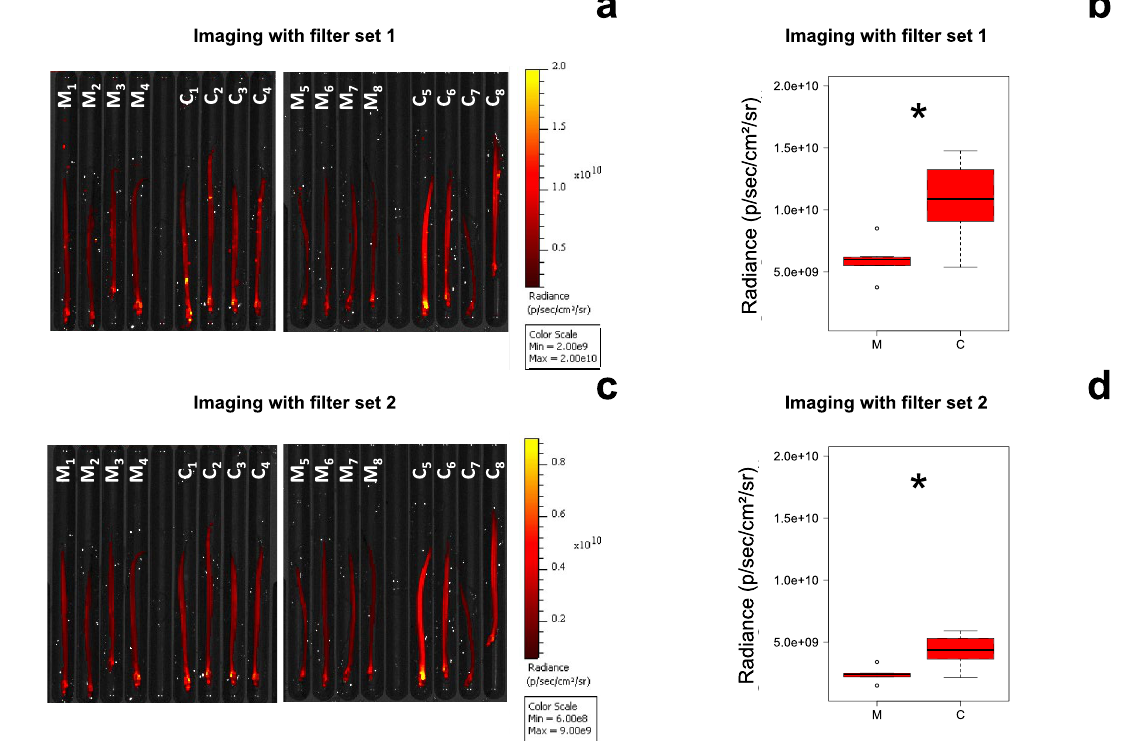
Figure 1. In vivo fluorescence reflectance imaging (FRI) of glass eels. Radiance of marked and control glass eels measured by FRI: ( a ) imaging and ( b ) boxplot with the filter set 1 at 450 nm–480 nm_515 nm–575 nm Ex_Em wavelengths; ( c ) imaging and ( d ) boxplot with the filter set 2 at 485 nm–515 nm_515 nm–575 nm Ex_Em wavelengths. Radiance is the fluorescence intensity expressed in p/sec/cm 2 /sr (photon/second/cm 2 /steradian). M: marked group. C = control group. *significant